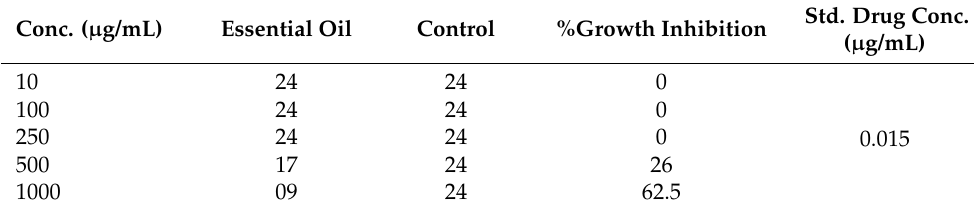
Table 3. Phytotoxic activity of U. dioica essential oil.